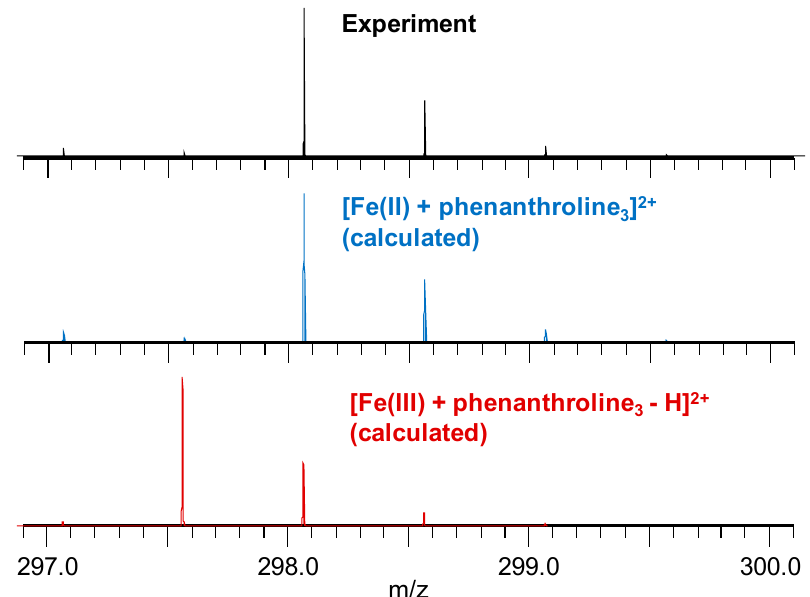
Figure A1. Mass spectrometry of [Fe(II) + 1,10-phenantroline 3 ] 2+ (10 μ M in H 2 O with 20 mM ammonium acetate) demonstrates stabilization of the Fe(II) oxidation state under these conditions.